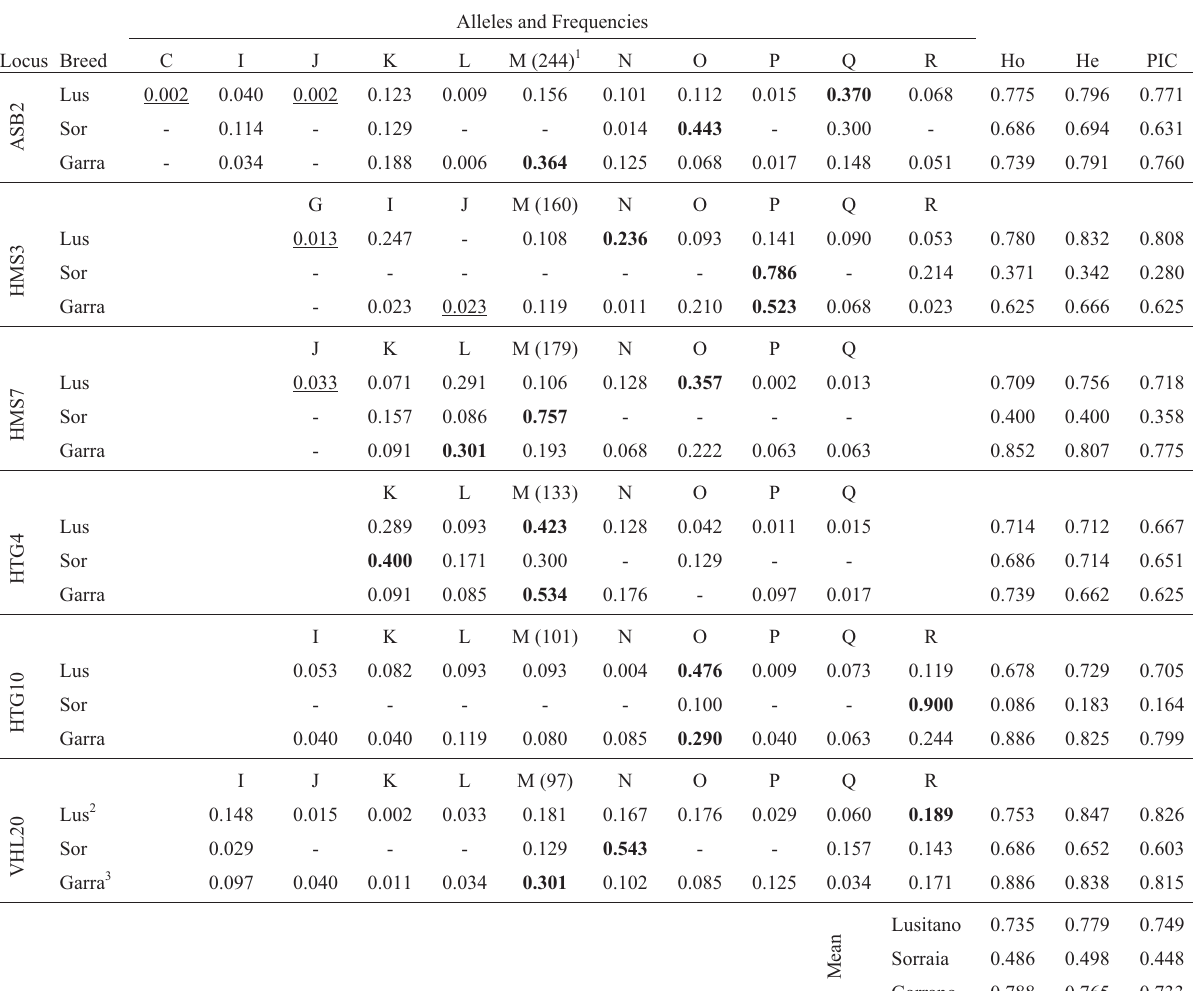
TableI -Allelefrequencies,observedheterozygosity(Ho),expectedheterozygosity(He)andpolymorphicinformationcontent(PIC)forLusitano(Lus), Sorraia (Sor) and Garrano (Garra) horse breeds. The exclusive alleles are underlined and the most frequent allele, for each breed, appears in bold. Alleles and Frequencies Locus